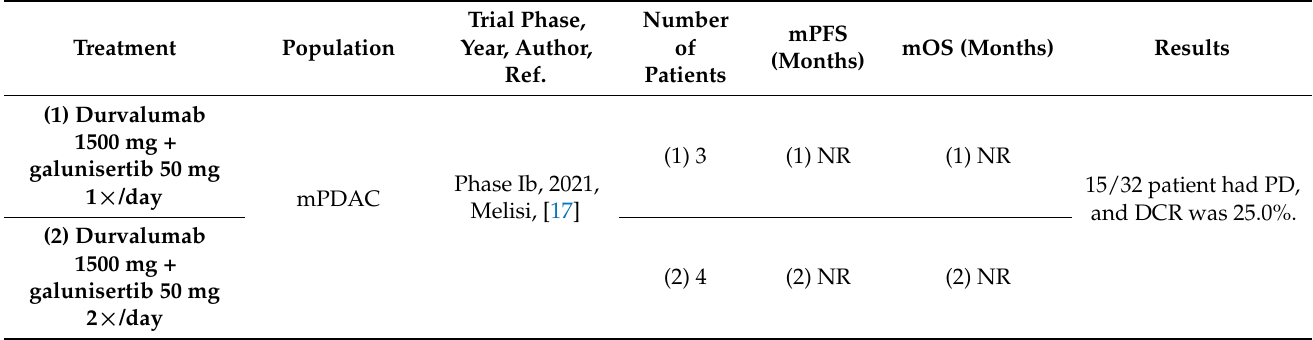
Table 1. Characteristics and results of published and completed trials with immune checkpoint inhibitors in